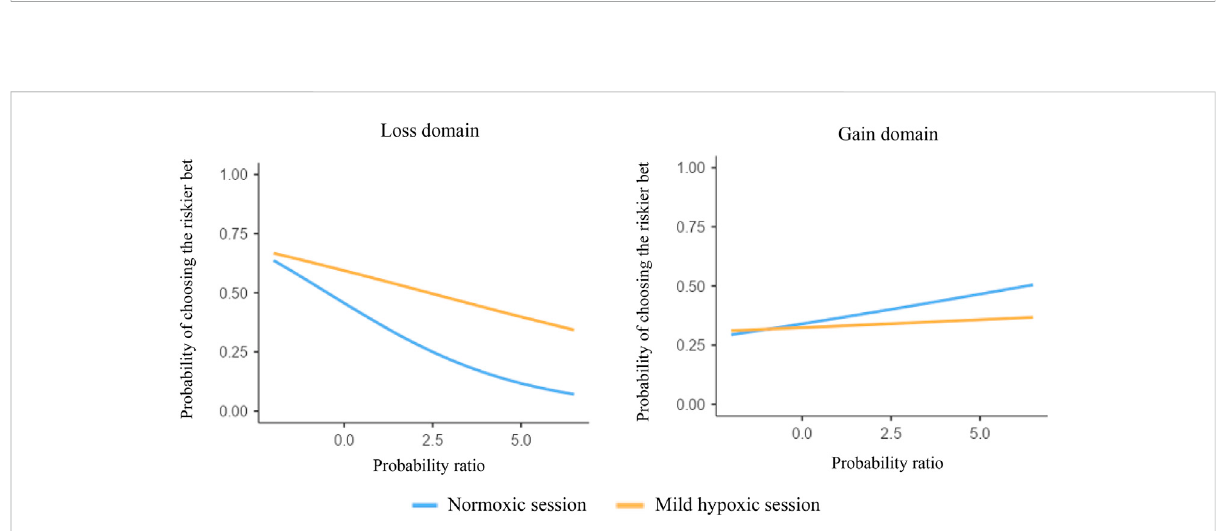
FIGURE 3 Percentage of choices of the riskier bet in the two sessions (normoxic and mild hypoxic) and for the two domains (losses and gains).